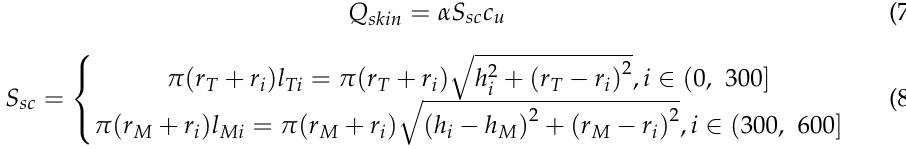
( c ) Figure 15. Normalized unit skin resistance: ( a ) helix number test sets, ( b ) helix size test sets, and ( c ) drilling speed test sets. 3.3.3. Tip and Skin Resistance As the bottom of the central steel pipe ( (cid:1860) (cid:3029) = 600 mm) was not installed with a strain gauge, it was necessary to estimate the skin resistance in the range of 500 mm to 600 mm to obtain the proportion of the skin resistance to the tip resistance for the entire pile shaft. The adhesion in the depth range of 340 mm to 500 mm was used as the basis to obtain the skin resistance in the range of 500 mm to 600 mm by Equation (7). The load bearing ca- pacity of the PGHP included the skin resistance and tip resistance of the pile shaft, as shown in Equation (9). (cid:1843) (cid:3004) = (cid:1843) (cid:3047)(cid:3036)(cid:3043) (cid:3397) cos(cid:2016) (cid:3035)(cid:3036) ∑(cid:1843) (cid:3046)(cid:3038)(cid:3036)(cid:3041) ,(cid:2016) (cid:3035)(cid:3036) (cid:3420) (cid:1860) (cid:3036) ∈ (cid:4666)0,300(cid:4667),(cid:2016) (cid:3035)(cid:3036) = (cid:2016) (cid:3021)(cid:3014) (cid:1860) (cid:3036) ∈ (cid:4666)300,600(cid:4667),(cid:2016) (cid:3035)(cid:3036) = (cid:2016) (cid:3014)(cid:3003) (9) where (cid:1843) (cid:3004) is the axial force at the depth of 60 mm (assumed equal to pile head load), (cid:1843) (cid:3047)(cid:3036)(cid:3043) is the tip resistance, (cid:2016) (cid:3035)(cid:3036) is the angle between the pile shaft and the soil, (cid:2016) (cid:3021)(cid:3014) is the angle between the pile shaft and the soil in the range between the pile shaft top and the pile shaft middle, and (cid:2016) (cid:3014)(cid:3003) is the angle between the pile shaft and the soil in the range between the pile shaft middle and the pile shaft bottom The tip resistance could be calculated by combining the skin resistance in the range of 60 mm to 600 mm using Equation (9). To further analyze the proportion of skin